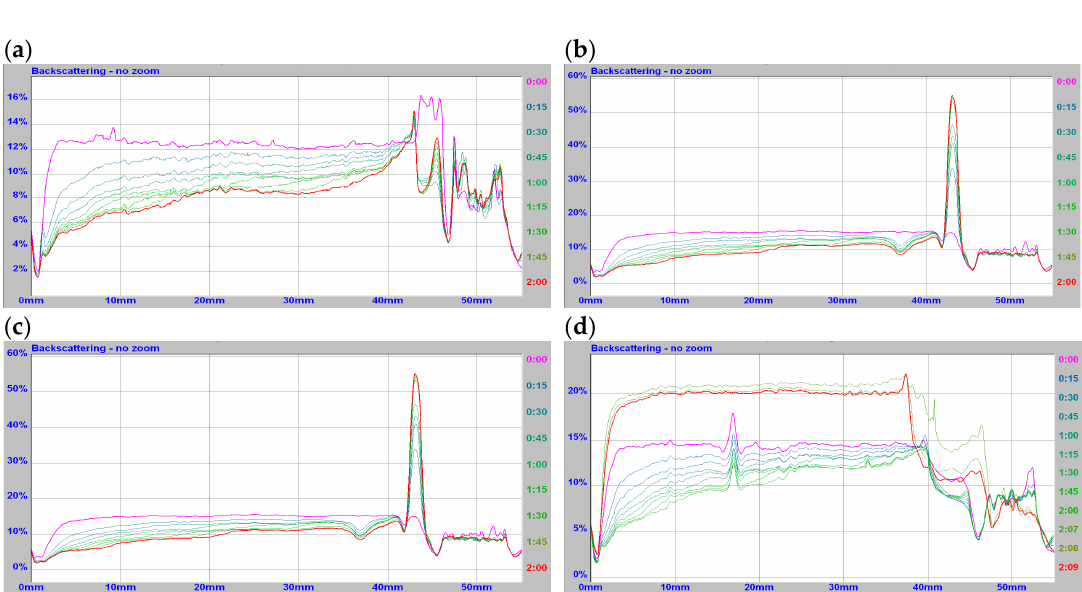
Figure 3. Changes of the backscattering light values for formulations of CsA/SO ( a , b ) and CsA, EtOH, DPPC/SO, Ch ( c , d ) respectively at 20 °C and 37 °C vs. time (0–2 h).